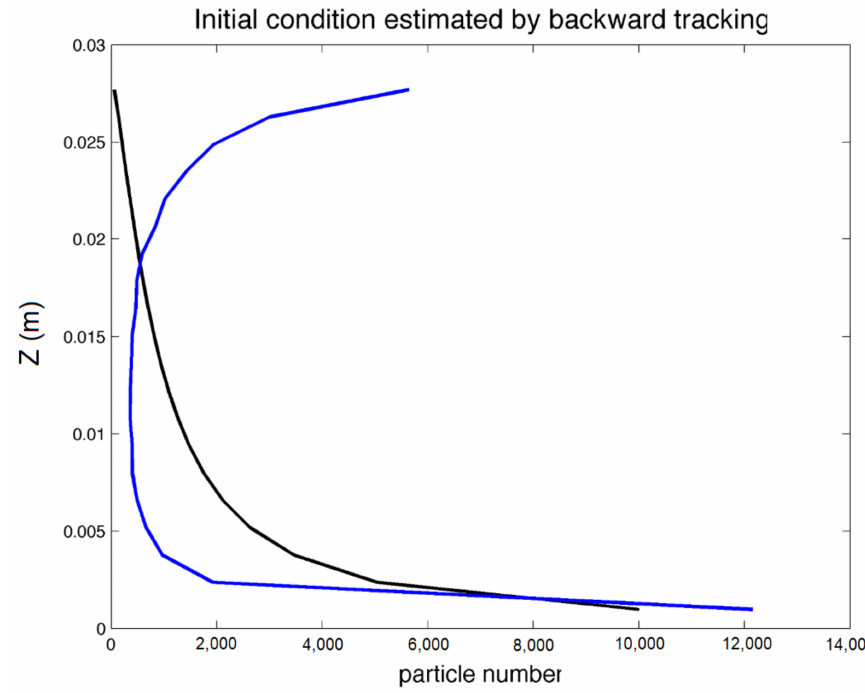
Figure 13. Sediment concentrations in the explicit backward simulation method.